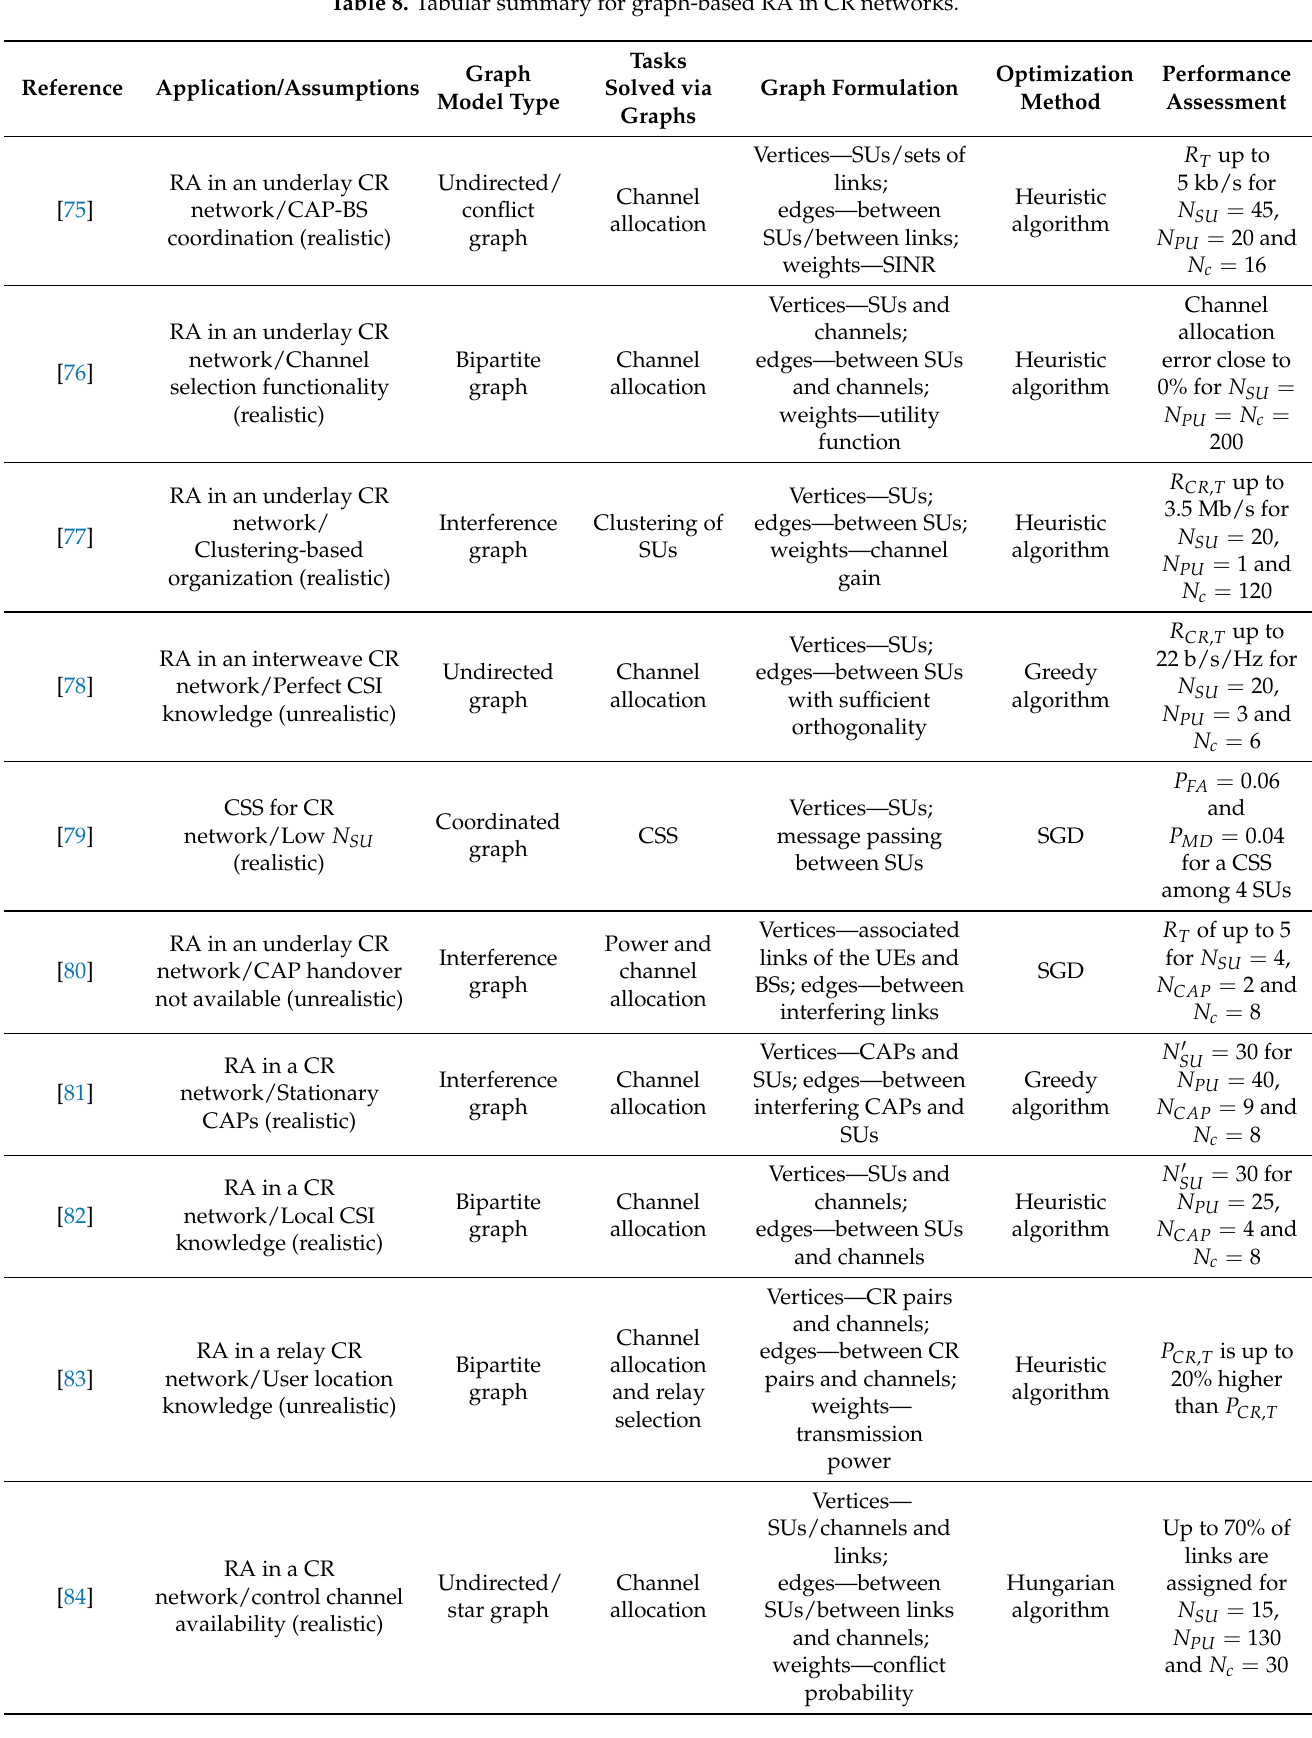
Table 8. Tabular summary for graph-based RA in CR